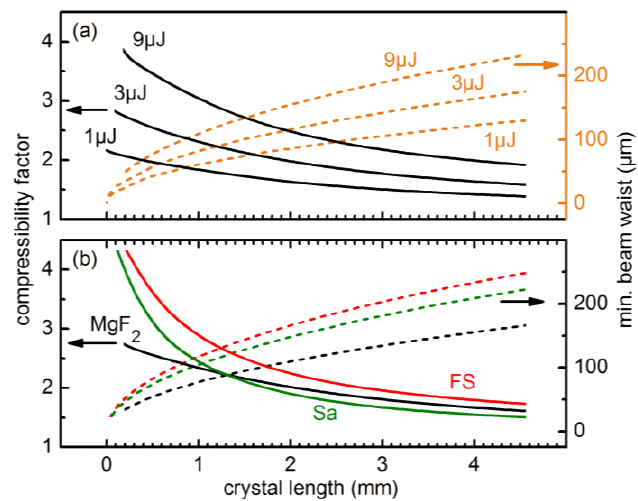
Figure 2. Compressibility factor (ratio between input and output Fourier limit) for a 25 fs pulse. Results for varied input energies, pulses centered at 308 nm, and a CaF and for different crystals with 266 nm pulses of 3 μJ energy ( b ). The input beam waist is set to a value for which the calculated self-focal length is 1.25 × the crystal